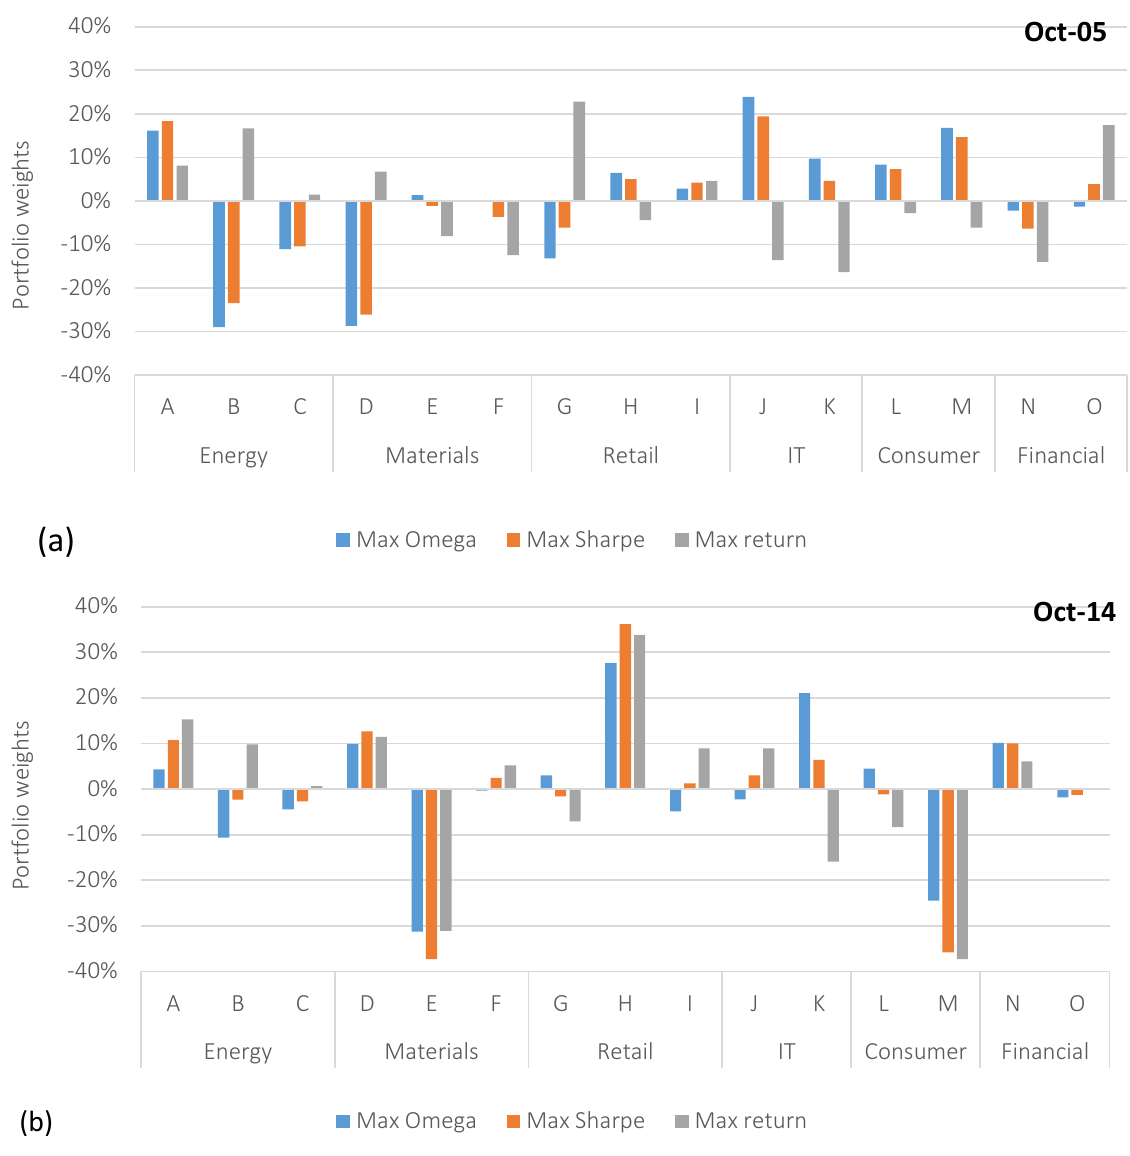
Figure 8. Benchmark weight deviations for relevant